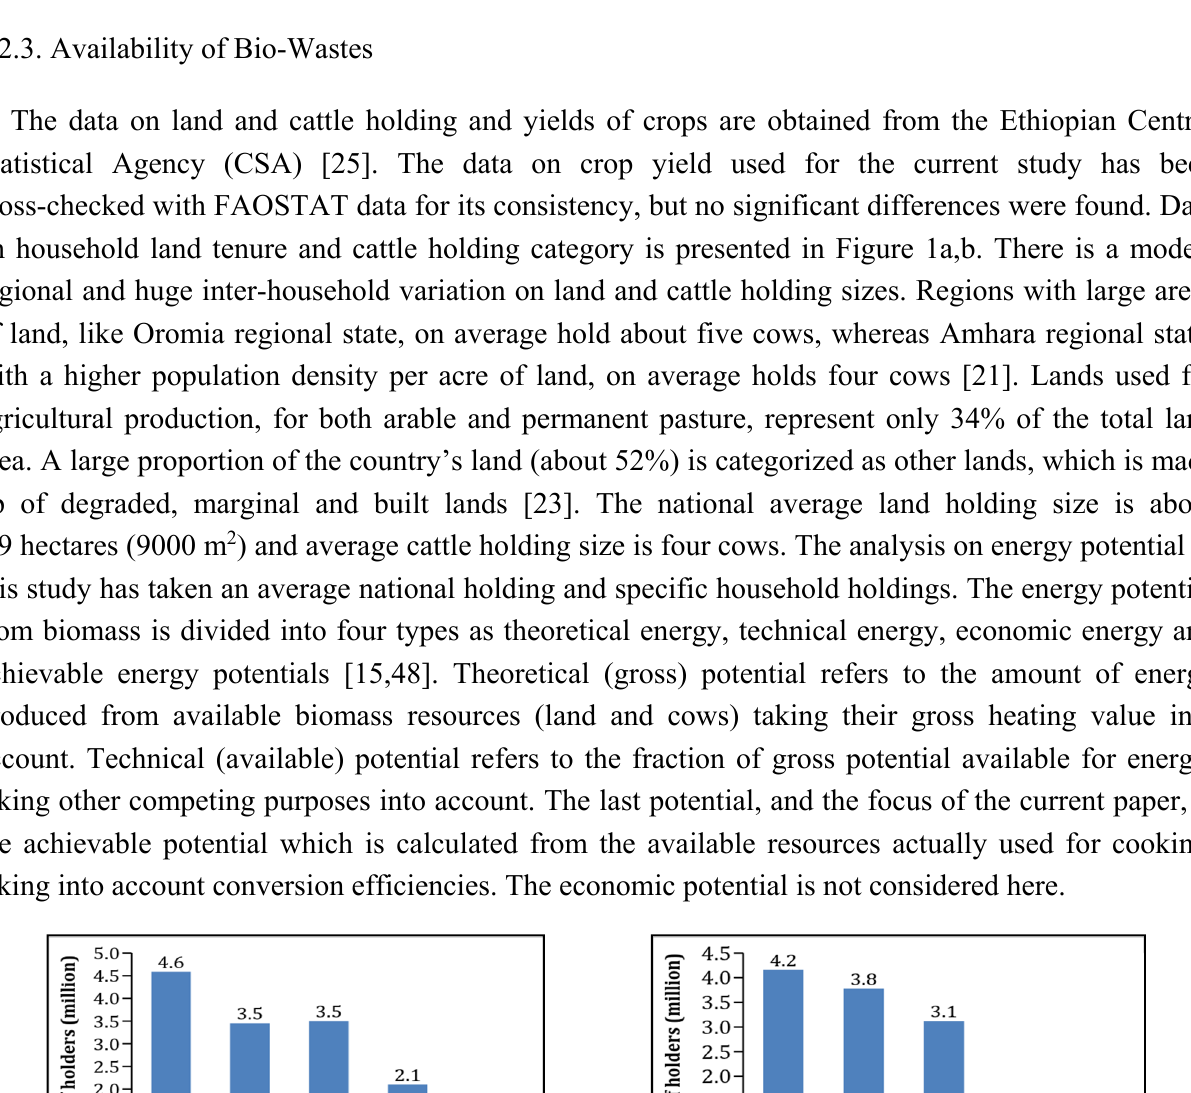
Table 1. Thermal output of the energy conversion systems with different bio-wastes. Stoves Technology Feedstock LHV (GJ/t) Efficiency (%) b Thermal output (GJ/t) TSF traditional residues or dung 15 10 1.5 ISB briquetting residues 19 20 Biogas AD residues Biogas AD